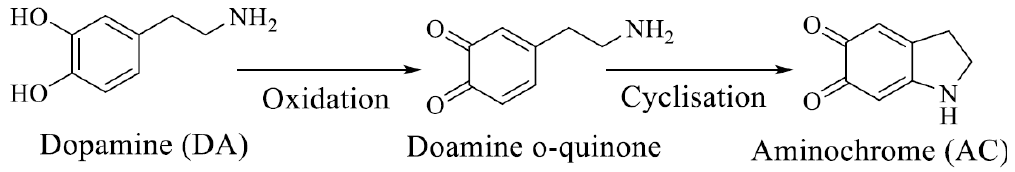
Figure 26. Structural formulae of the V IV O-complexes prepared in this work. Adapted from Ref. [160], Copyright (2020) with permission of Royal Socaity of Chemistry.